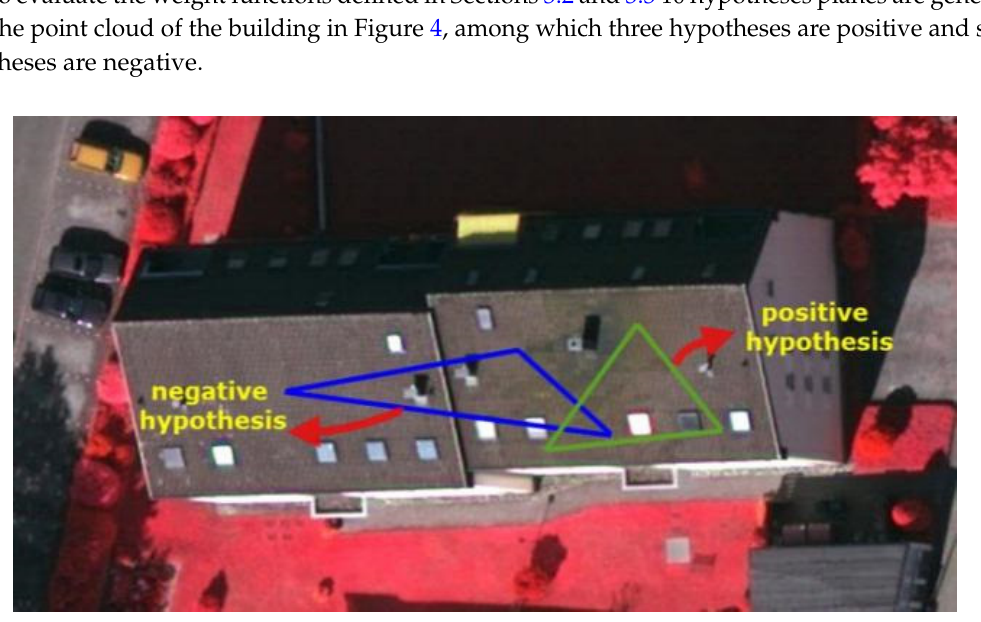
Figure 4. Buildings with both positive and negative hypotheses. The deep blue triangle is a negative hypothesis as it is athwart the two roof planes, and the cyan triangle is a positive hypothesis which can produce a correct segmentation.